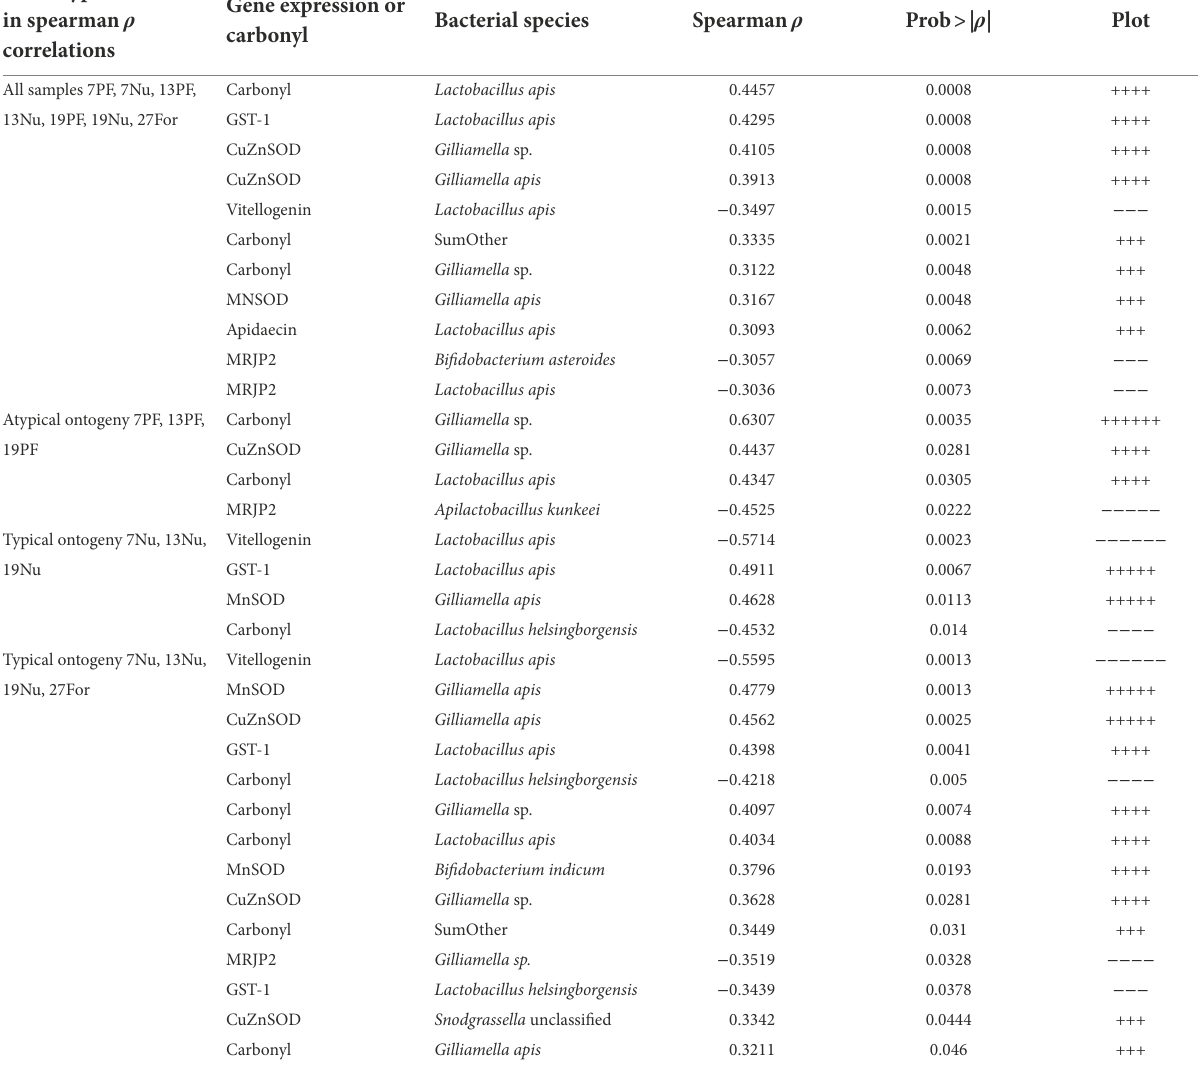
TABLE 1 Summary of Spearman rank correlations of ileum OTU absolute abundance, carbonyl, and fat body gene expression that were determined significant after FDR correction ( p < 0.05) for various phenotypes. Phenotypes